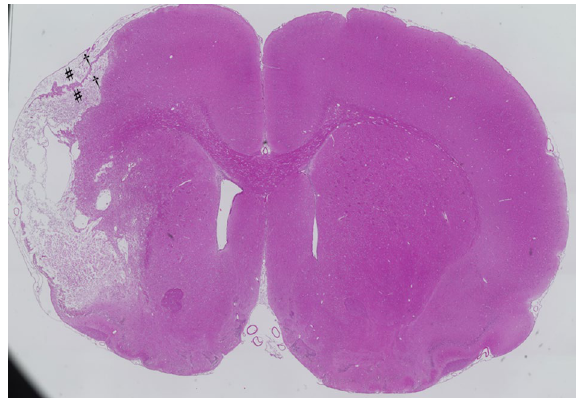
Figure 4. Hematoxylin and eosin (H&E) staining 28 days after middle cerebral artery occlusion. The H&E- stained segments show cerebral infarction in the middle cerebral artery region, # indicates forelimb sensory- motor overlap area and † indicates hindlimb sensory-motor overlap area. No brain contusion was observed by bone shaving or electrical